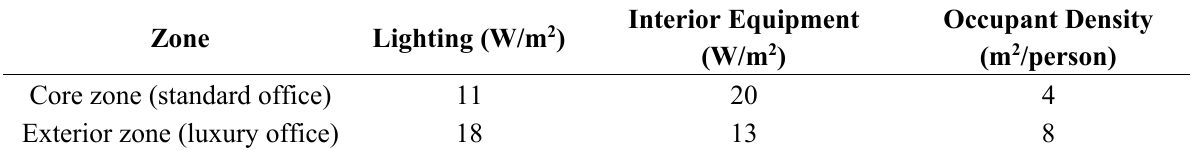
Table A4. Interior loads for the GB 50189–2005 code-compliant building model.